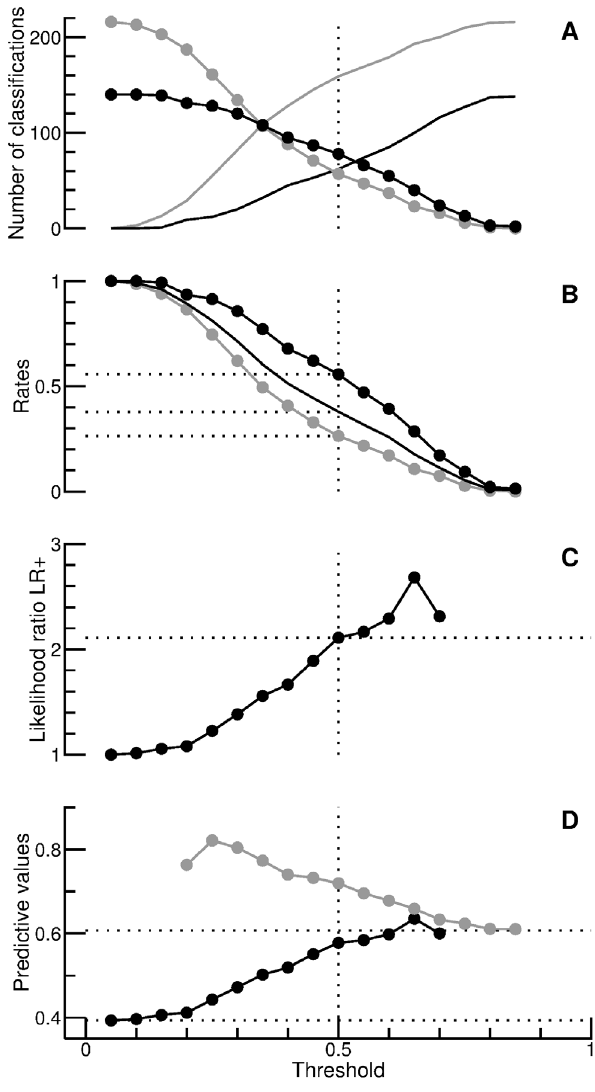
Figure 2. Prediction of a positive outcome of the glycerol test by K-nearest neighbor classification. (A) The curves with filled circles show, as a function of threshold, the numbers of true-positive (black) and false-positive predictions (gray). The other curves show the numbers of false-negative (black) and true-negative predictions (gray). (B) The curves with filled circles show the true-positive rate (black) and the false-positive rate (gray). The other curve shows the rate of positive predictions, corresponding to the proportion of candidate patients that would be subjected to testing. (C) Likelihood ratio LR z . (D) Positive predictive value (black) and negative predictive value (gray).